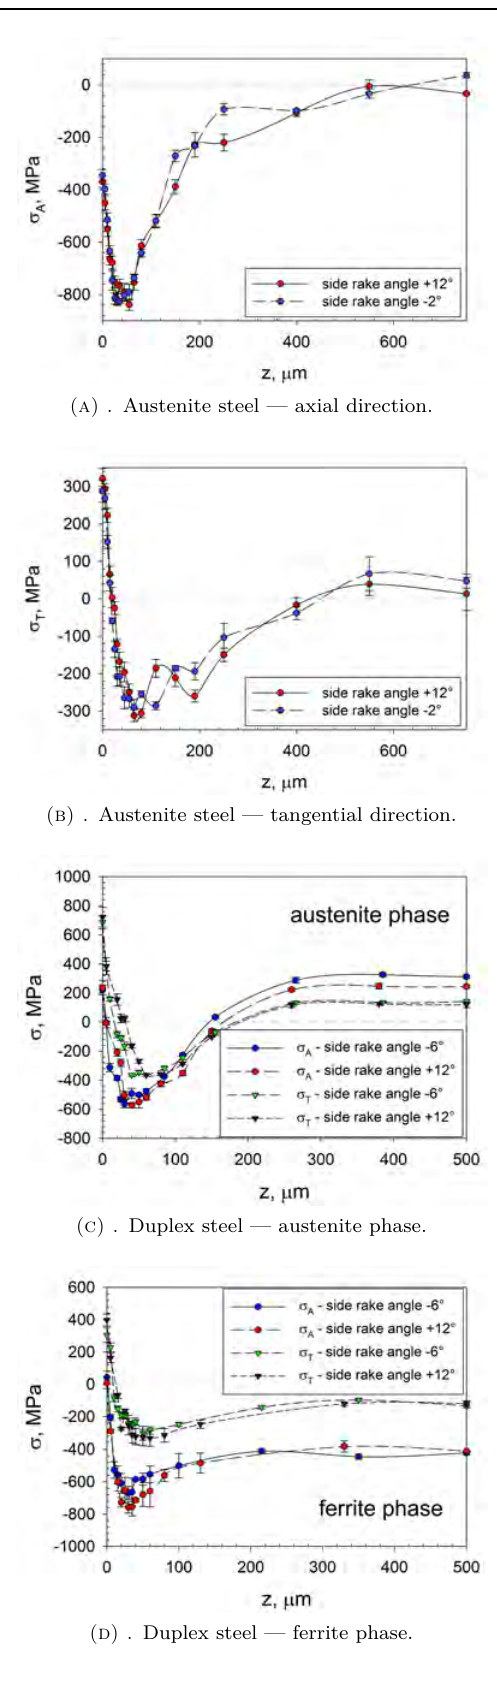
Figure 3. Residual stress gradients σ rake angles − 6 ◦ , − 2 ◦ and +12 ◦